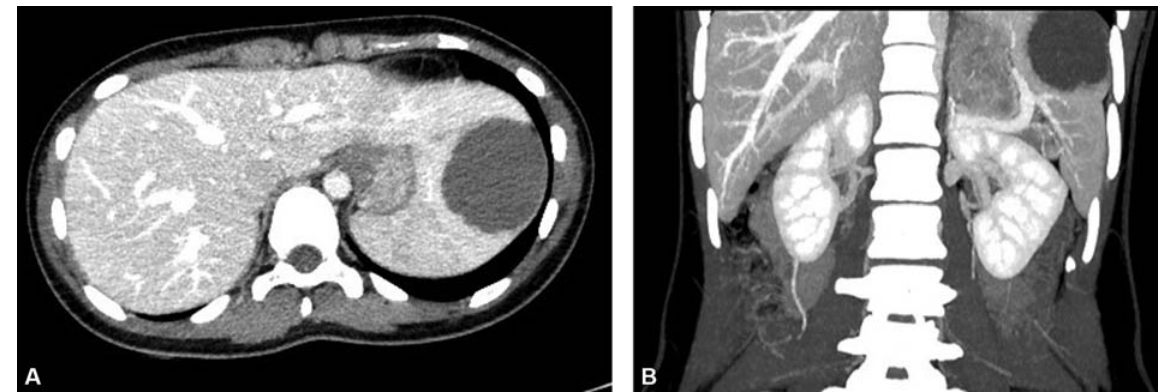
Fig.1 Computed tomography withintravenous contrast. Axial ( A ) andcoronal ( B ) sectionsinvenousphase. A hypodense 48.8 (cid:1) 55.2-mm lesion with a rounded morphology was observed in the anterior, cranial, and lateral region of the spleen, intimately related to the hilum.